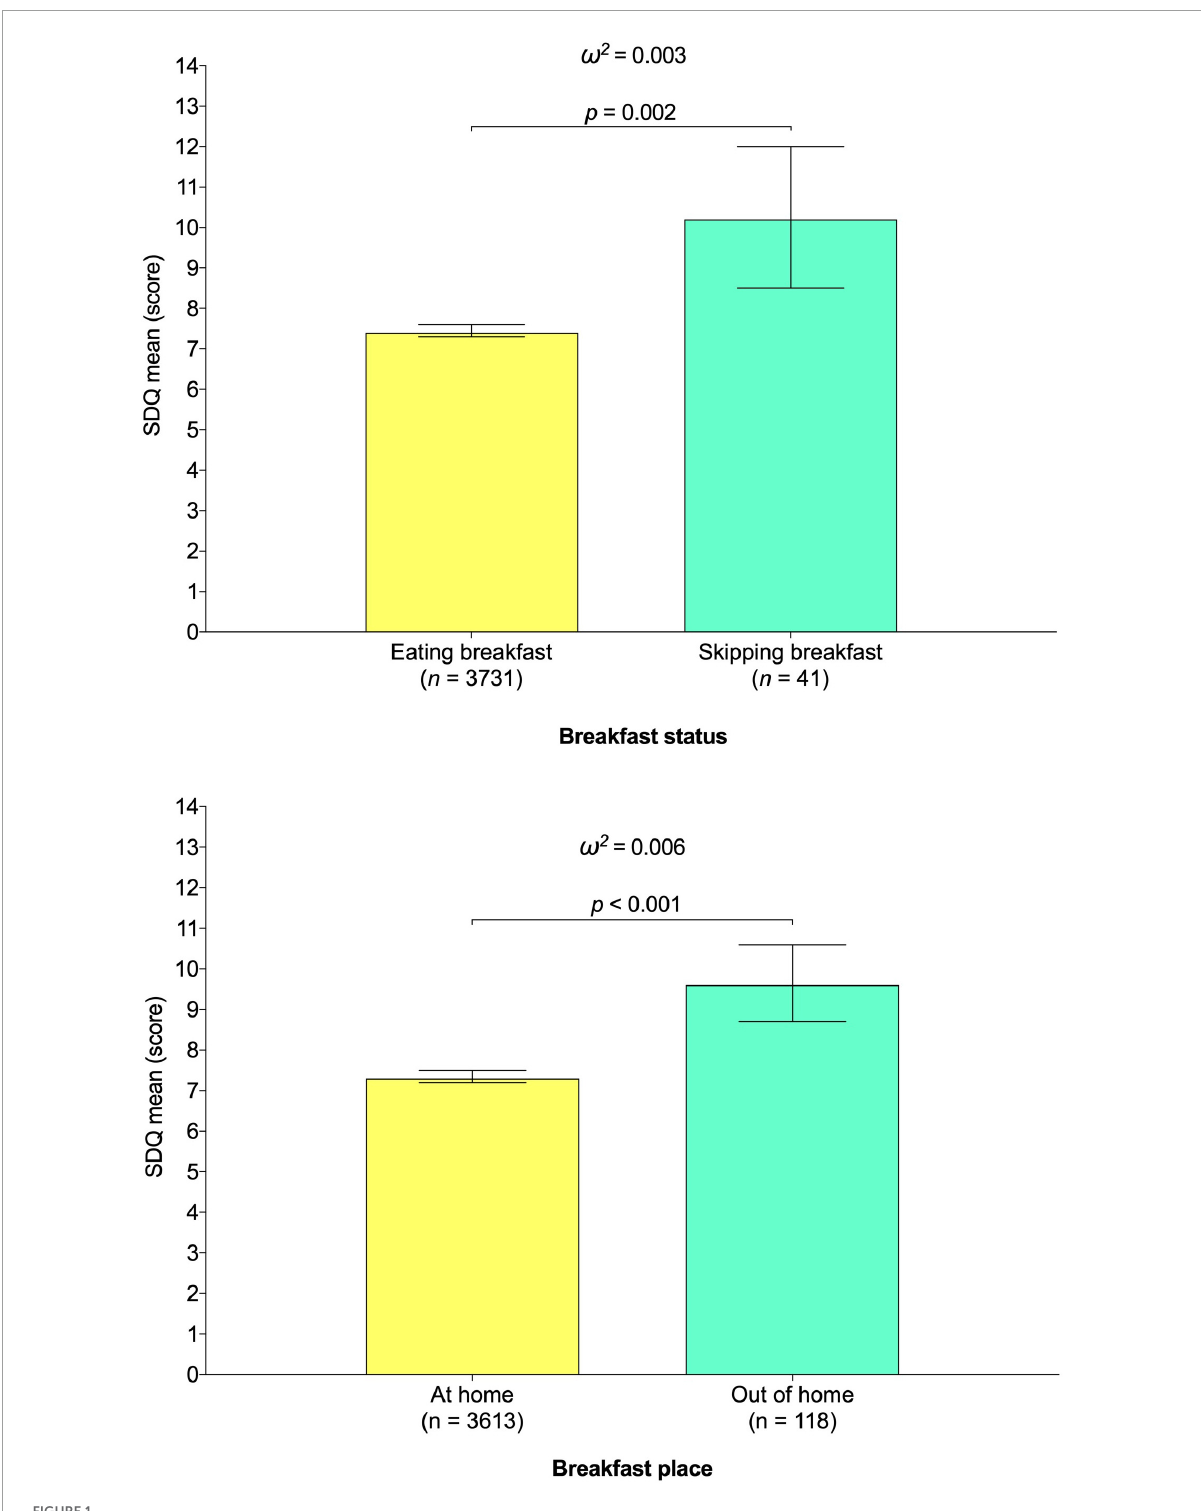
FIGURE1 Association between breakfast status and breakfast place and Strengths and Difficulties Questionnaire mean score in young population. Estimated mean (bars) and 95% CIs (lines) represent values after adjustment for age, sex, region, social class, immigrant status, excess weight, physical activity level, recreational screen time, sleep duration, Spanish Healthy Eating Index score, and breakfast